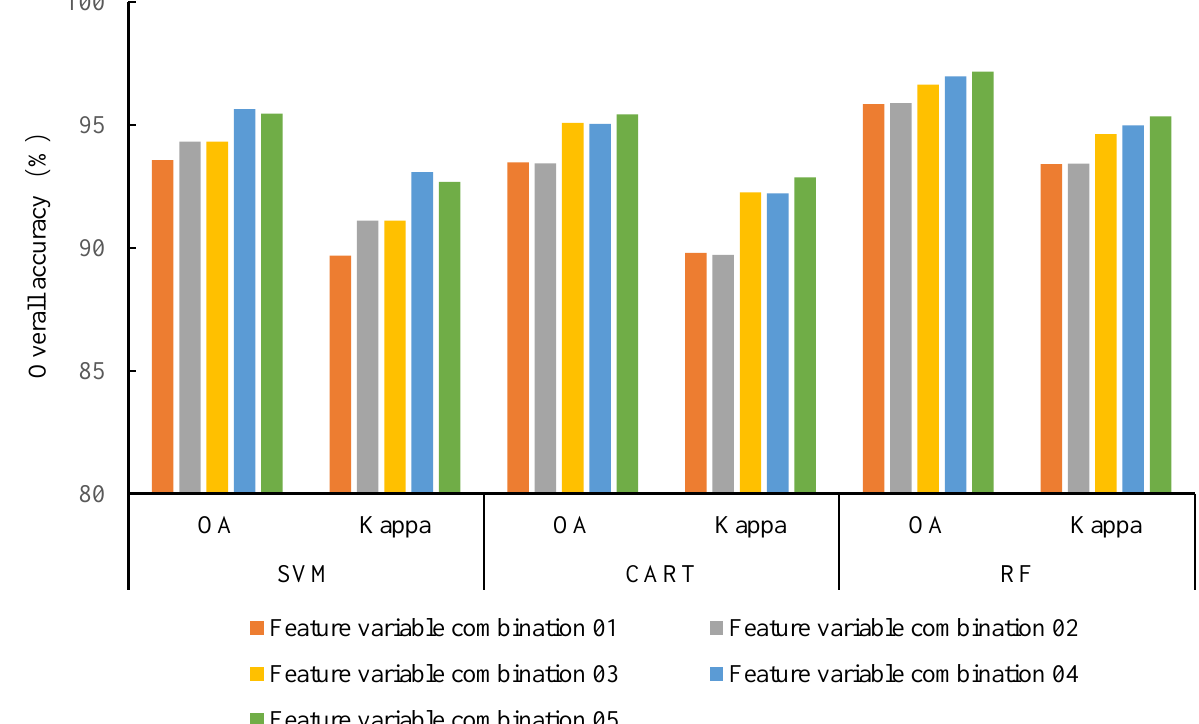
Figure 5. The influences of the different feature variable combinations on the overall accuracy (OA) of the classification results. Feature variable combination 01: spectral bands; feature variable combination 02: spectral bands + spectral indices; feature variable combination 03: spectral bands + spectral indices + terrain features; feature variable combination 04: spectral bands + spectral indices + terrain features + radar features); feature variable combination 05: spectral bands + spectral indices + terrain features + radar features + texture features.